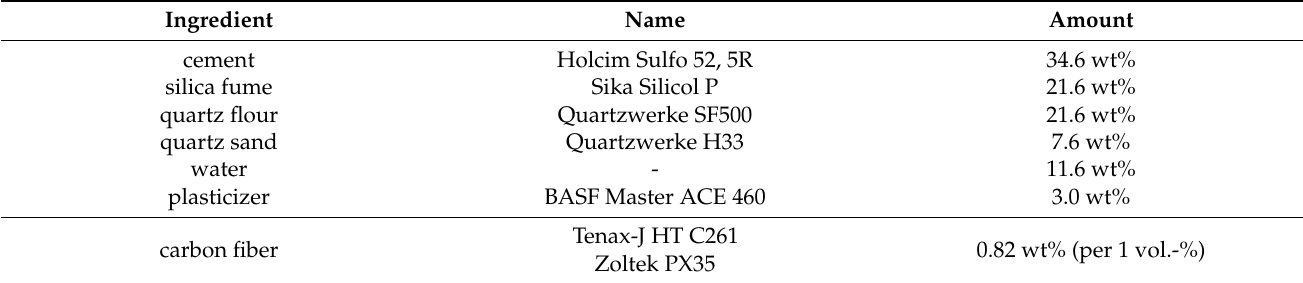
Table 1. Concrete recipe for CSFRC with 3D printing ability. Carbon fibers are added additionally to the amounts